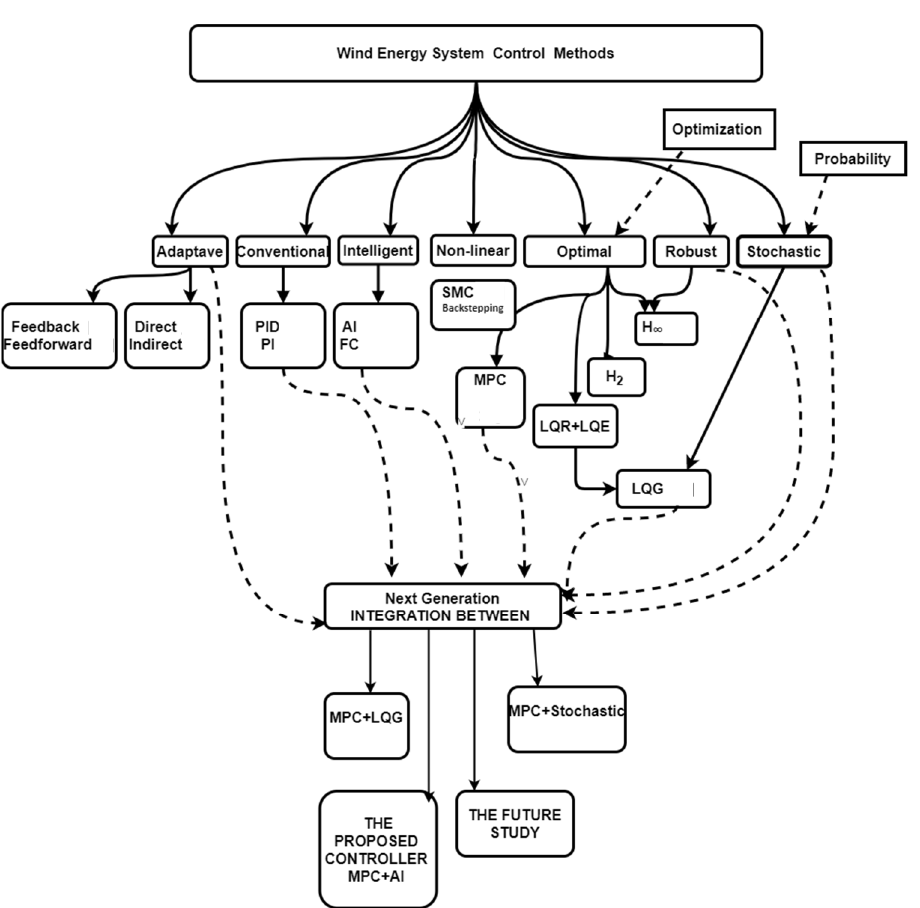
Figure 2. Control strategies for wind energy conversion system